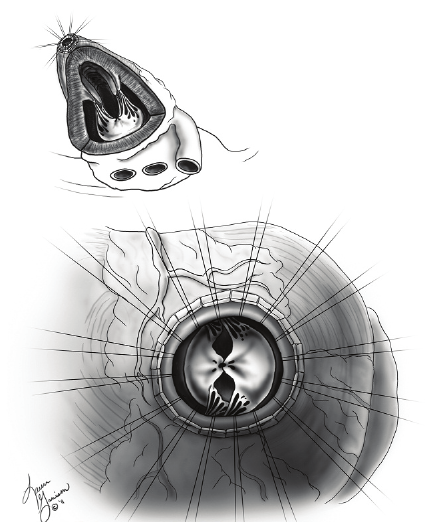
Figure 1: Apical sutures placed with Teflon pledgets in a horizontal mattress